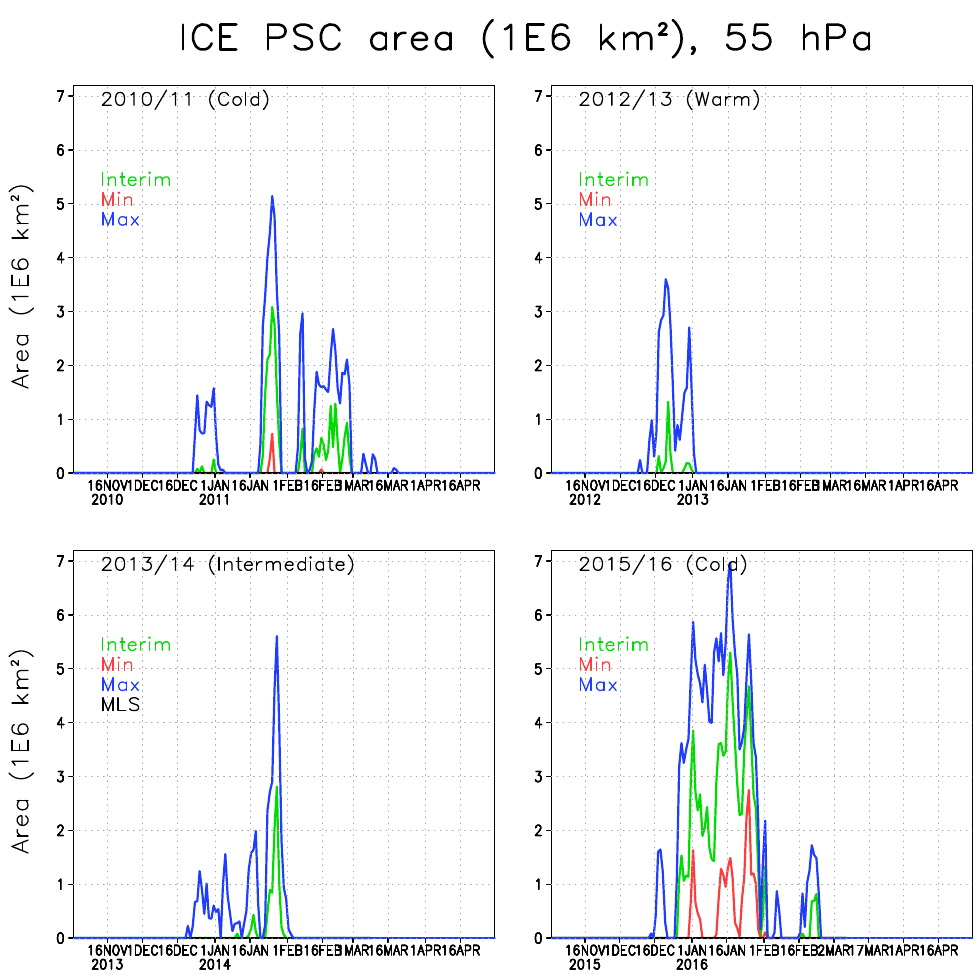
Figure 4. The areas of ICE PSCs (10 6 km 2 ) within the Arctic polar vortex in the FinROSE simulations at 55hPa. The green line denotes the Interim simulation, blue denotes the Max simulation and red denotes the Min